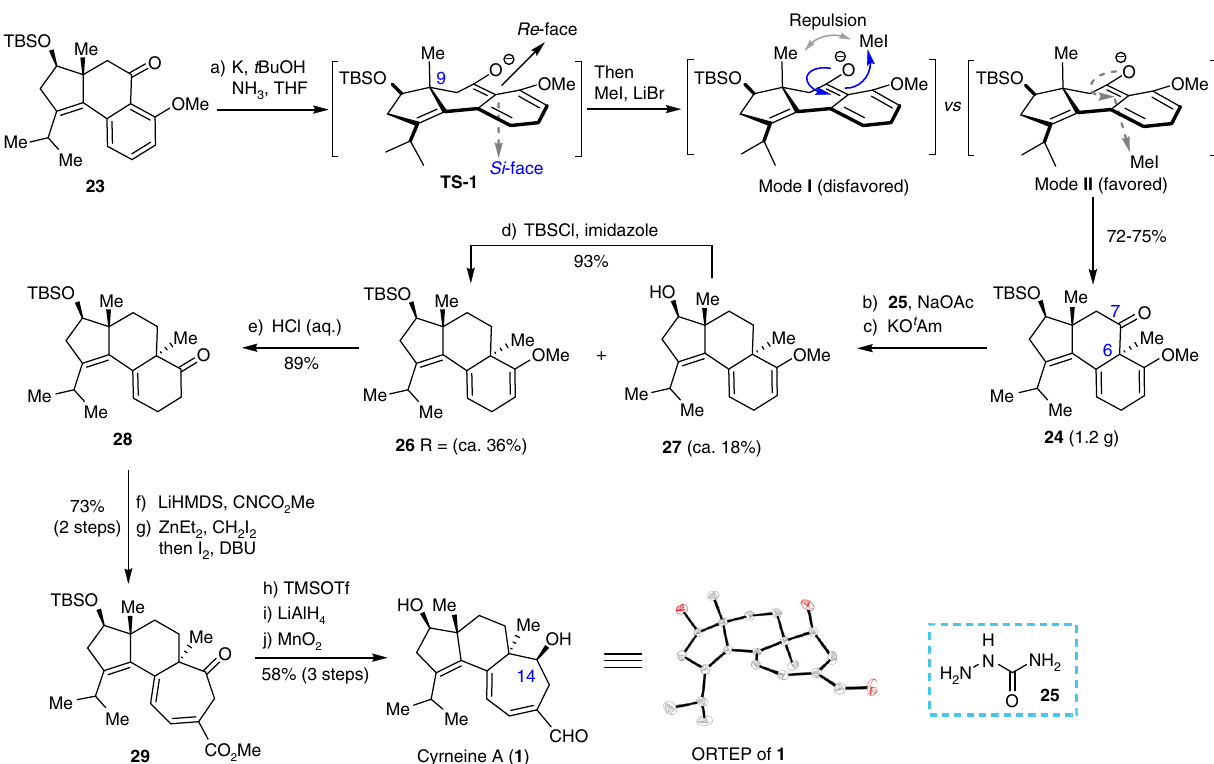
Fig. 5 The completion of the synthesis of cyrneine A. Reagents and conditions: (a) Liq. NH 3 , t BuOH (1.0 equiv), K (2.5 equiv), Et 2 O, − 78 °C, 10 min; then LiBr (2.5 equiv), MeI (5.0 equiv), and THF were charged in situ, − 78 °C, 1 h, then warmed to rt over a period of 1 h (72%); (b) 25 (5.0 equiv), NaOAc (5.0 equiv), EtOH, 35 °C, 3 h; (c) KO t Am (5.0 equiv), degassed xylene, 140 °C, 1.8 h (36% for 26 ; 18% for 27 ); (d) TBSCl (1.2 equiv), imidazole (1.2 equiv), DMF, rt, overnight (93%); (e) 5% aq. HCl, THF, 15 to 20 o C, 40 min (89%); (f) LiHMDS (1 M in THF, 3.5 equiv), CNCO 2 Me (3.0 equiv), THF, − 78 °C, 1 h; (g) ZnEt 2 (1.0 M in hexane, 6.0 equiv), CH 2 I 2 (6.0 equiv), CH 2 Cl 2 , rt, 2 h; I 2 (7.0 equiv), rt; then saturated aq. Na 2 S 2 O 3 (excess), rt; then DBU (20.0 equiv), rt, 10 min (73% for 2 steps); (h) TMSOTf (5.0 equiv), CH 2 Cl 2 , -25 o C, 15 min; (i) LiAlH 4 (6.0 equiv), Et 2 O, 10 min at − 78 °C, then warmed to rt; (j) MnO 2 (50 equiv), CH 2 Cl 2 , rt, overnight (58% in 3 steps); t Am = tert -amyl; DBU = 1,8-diazabicyclo[5.4.0]undec-7-ene; TMSOTf =